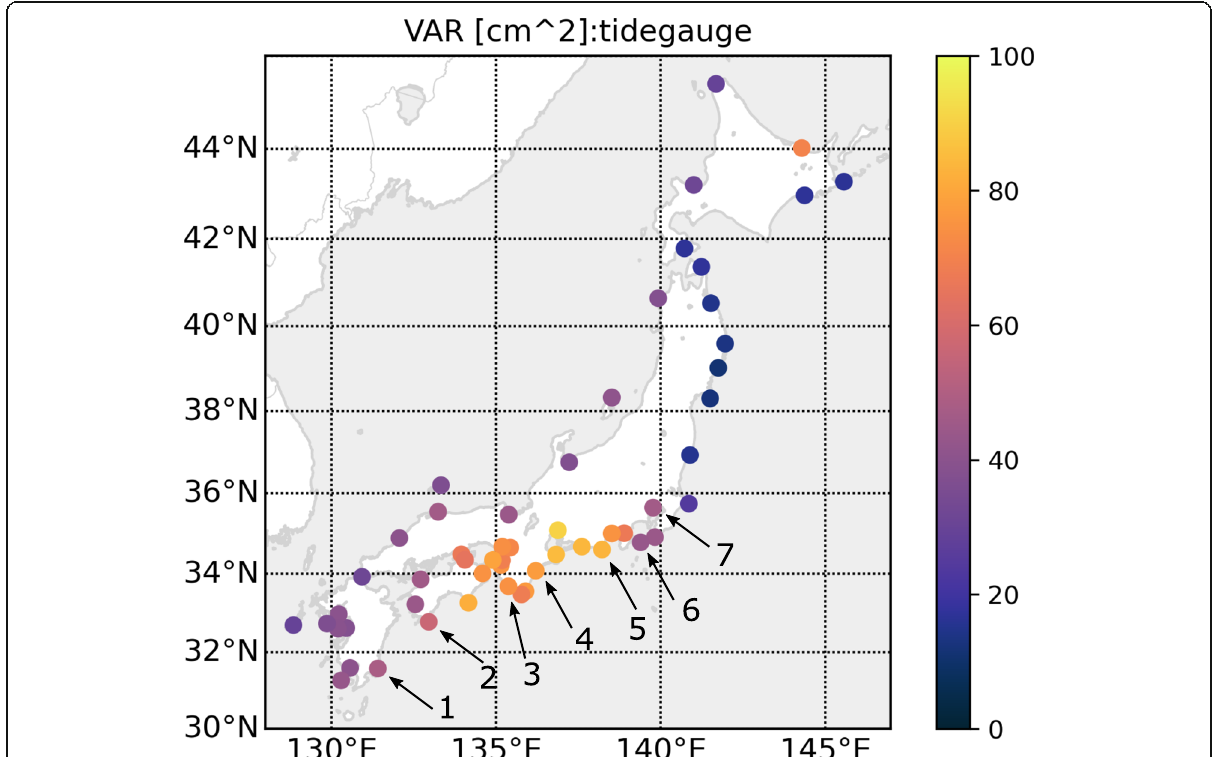
Fig. 12 Variances (cm 2 ) in the sea level along the coast of Japan denoted by colored circles, from the coastal tide gauge observation data (1997 – 2005) by the Japan Meteorological Agency (JMA), which is the daily mean data, excluding tidal variation. The calculation of variance was based on a daily anomaly from the daily climatology (and so the effect of the seasonal cycle was excluded). The seven points denoted by the arrows are used in Fig.